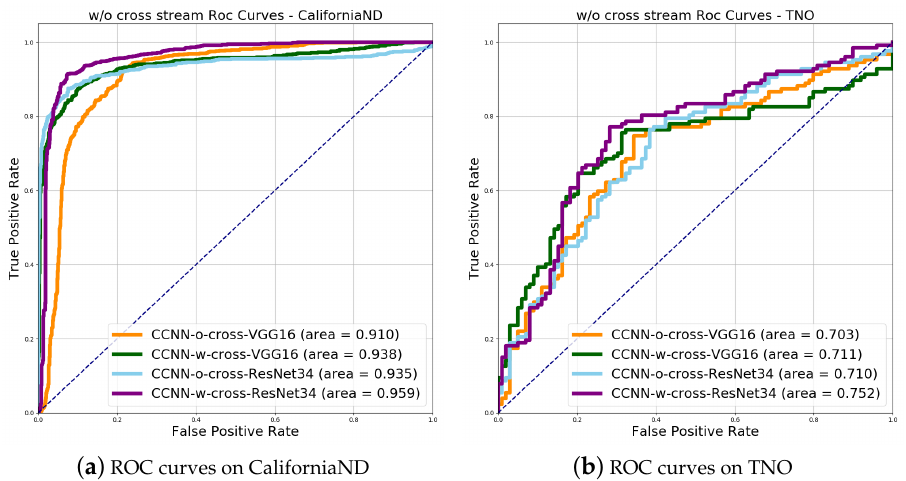
Figure 6. Illustration of ROC curves of networks with/without cross stream on single-modality and cross-modality. In both scenarios, CCNN-w-cross networks obviously perform better than CCNN-o-cross